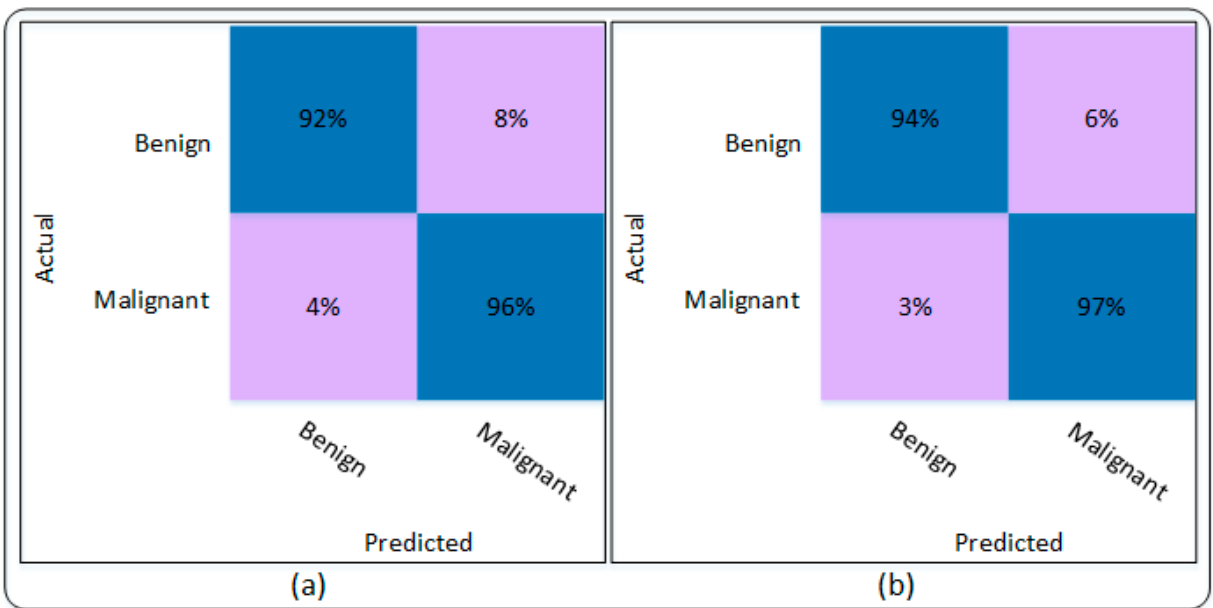
Table 4. Classification results using Modified DenseNet201.